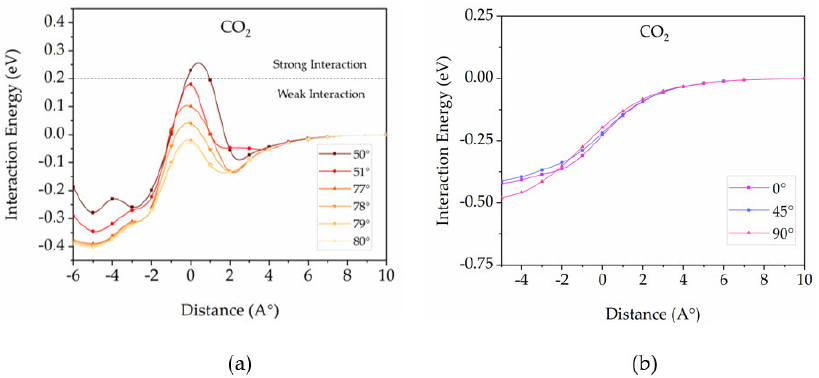
Figure 11. Interaction energies between ( a ) 3D pillared SiC (5,5) nanostructure and CO 2 gas mole- cules with some fine orientations, ( b ) 3D pillared C (6,6) nanostructure and CO 2 gas molecule with various orientations as a function of distance.